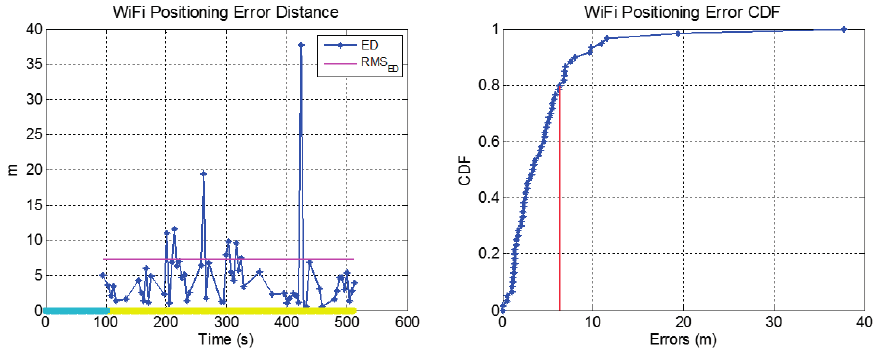
Figure 20. WiFi position errors at ENB.